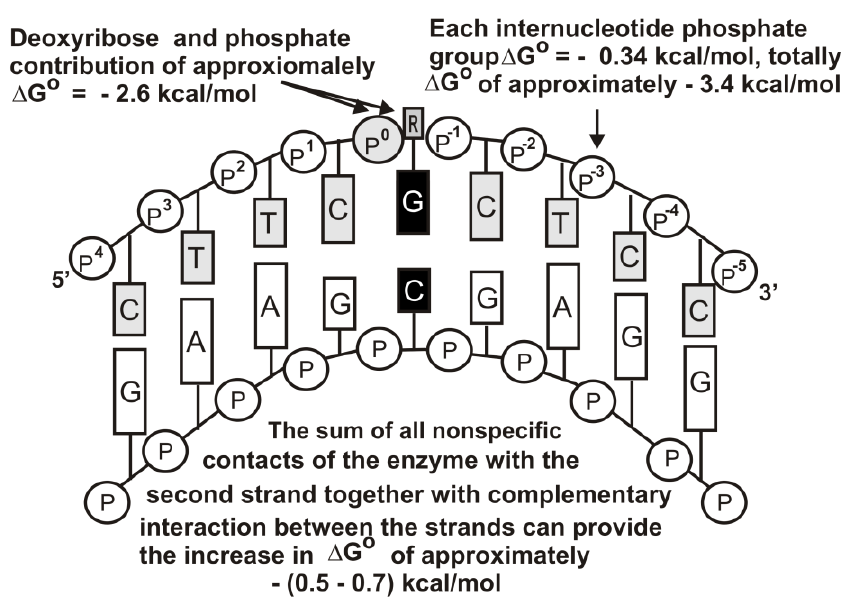
Figure 6. The thermodynamic model of hOGG1 interaction with unspecific DNA. All types of unspecific contacts are shown on the Panel [59]. The enzyme forms weak additive contacts only with internucleoside phosphate groups of DNAs except for one deoxyribose phosphate.